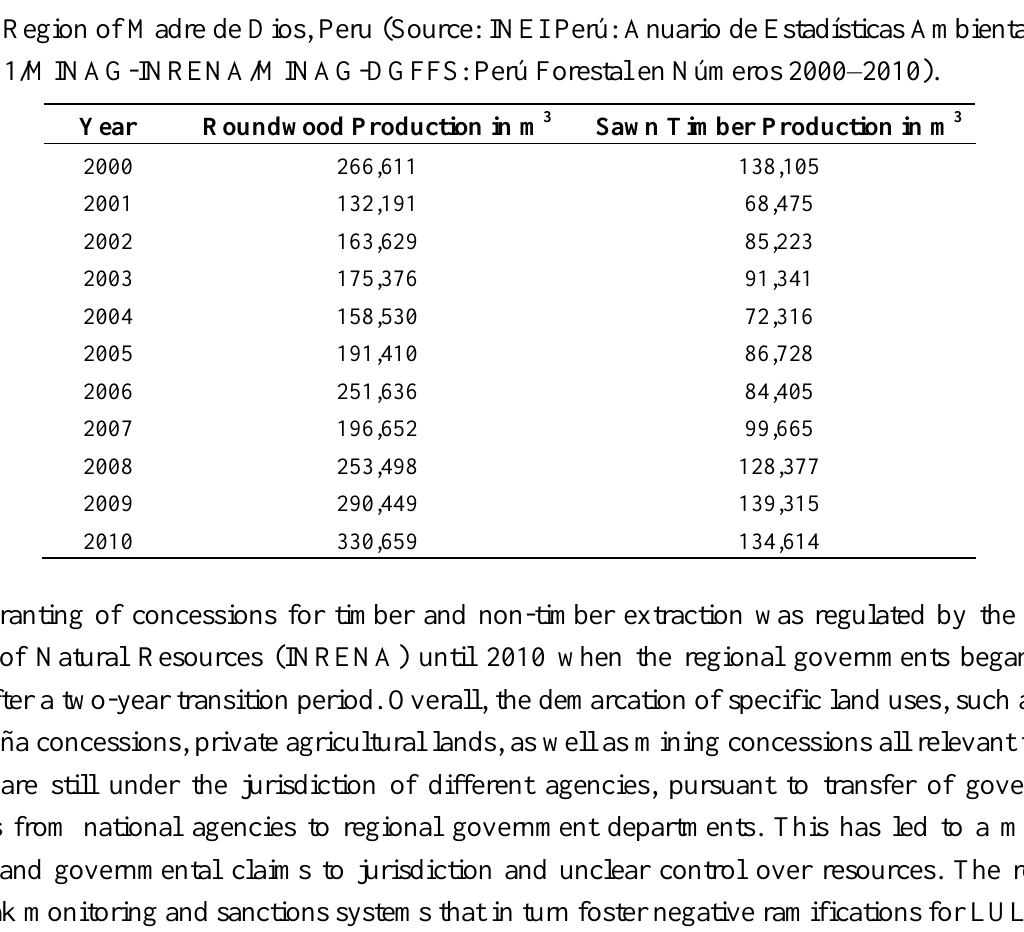
Table 2. Roundwood and Sawn Timber Production in cubic meters from 2000 to 2010 for the Region of Madre de Dios, Peru (Source: INEI Perú: Anuario de Estadísticas